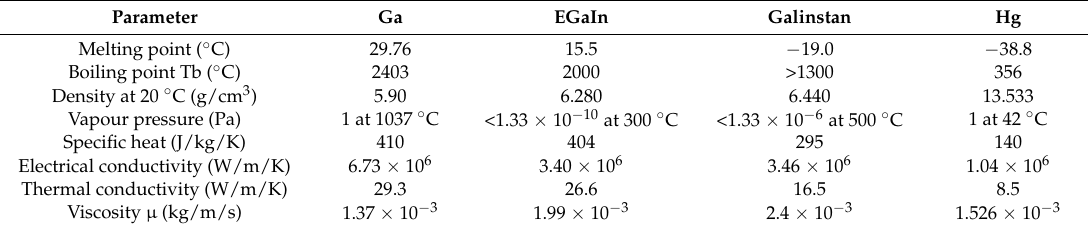
Table 1. Physical properties of gallium (Ga), Ga-based alloys, and mercury (Hg) [5–8,10–12]. Parameter Ga EGaIn Galinstan Hg Melting point ( ◦